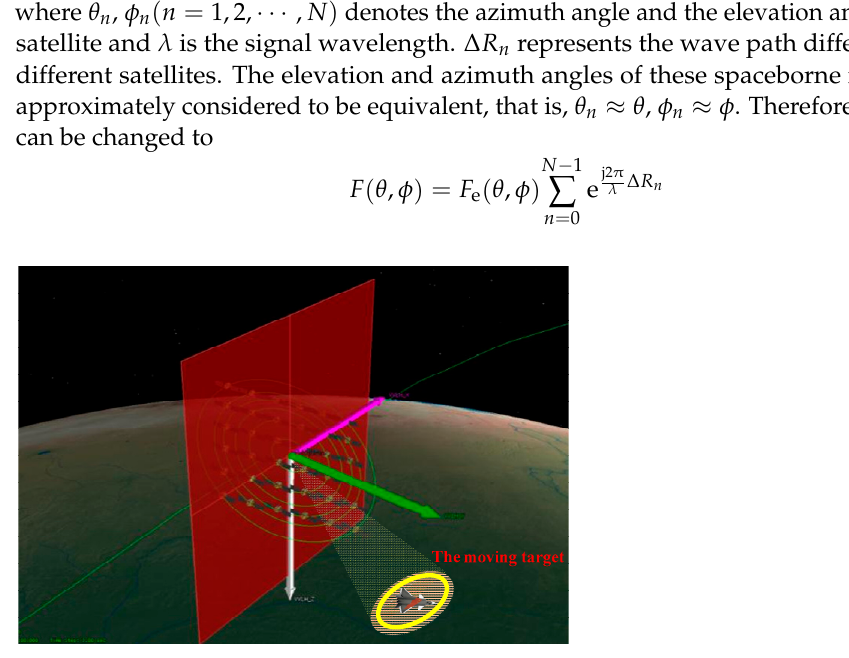
Figure 1. The dynamic coherent radar detection diagram.